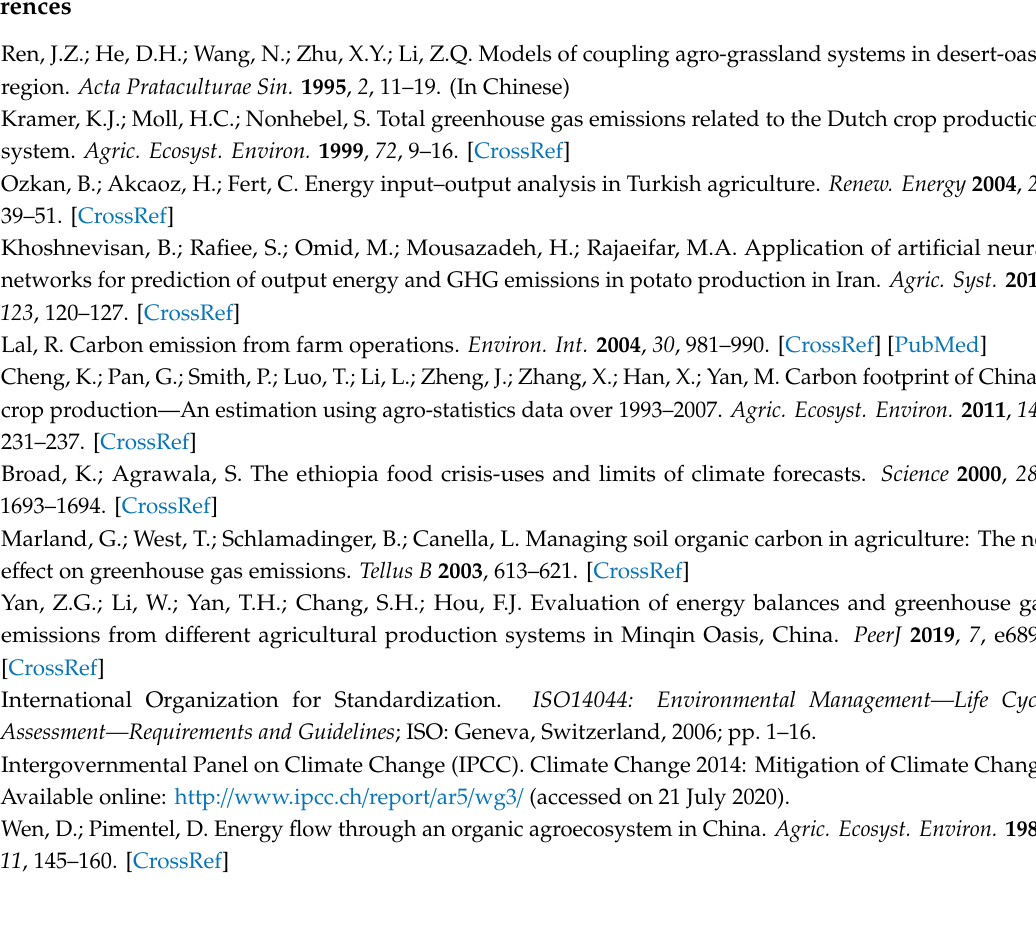
Figure S1: Longitudinal section of Shihezi study site to show Mountain-Oasis-Desert coupling ecological system (84 ◦ 58 (cid:48) –86 ◦ 64 (cid:48) E), Table S1: Average data of climate, crop, and livestock of the three sub-oases in the Shihezi Oasis (2015–2016), Table S2: The structured questionnaire of farm survey, Table S3: Average market price of inputs and direct, indirect and total e ff ects between dependent variables and predict